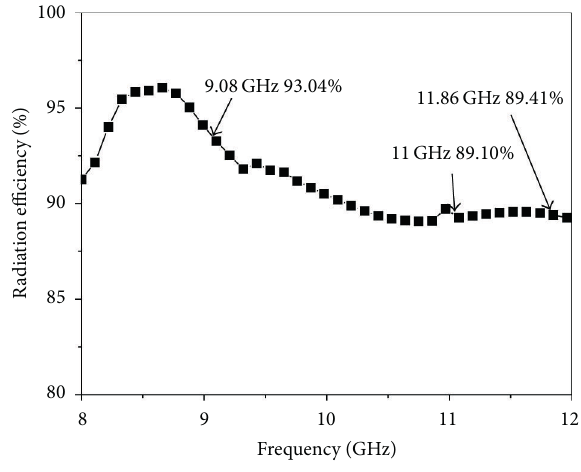
Figure 9: Radiation efficiency of the proposed antenna.